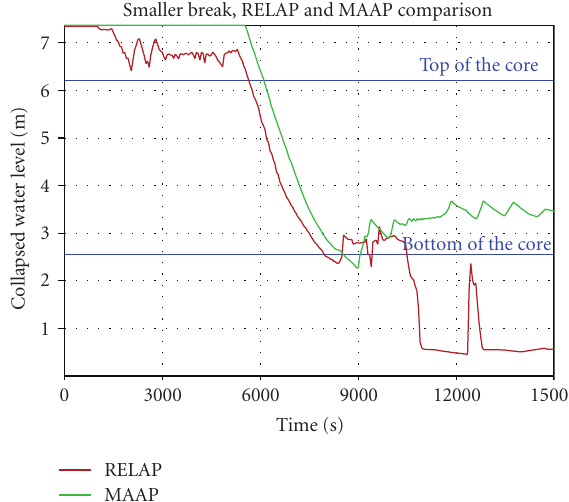
Figure 8: Collapsed water level in the reactor vessel, Group 1.